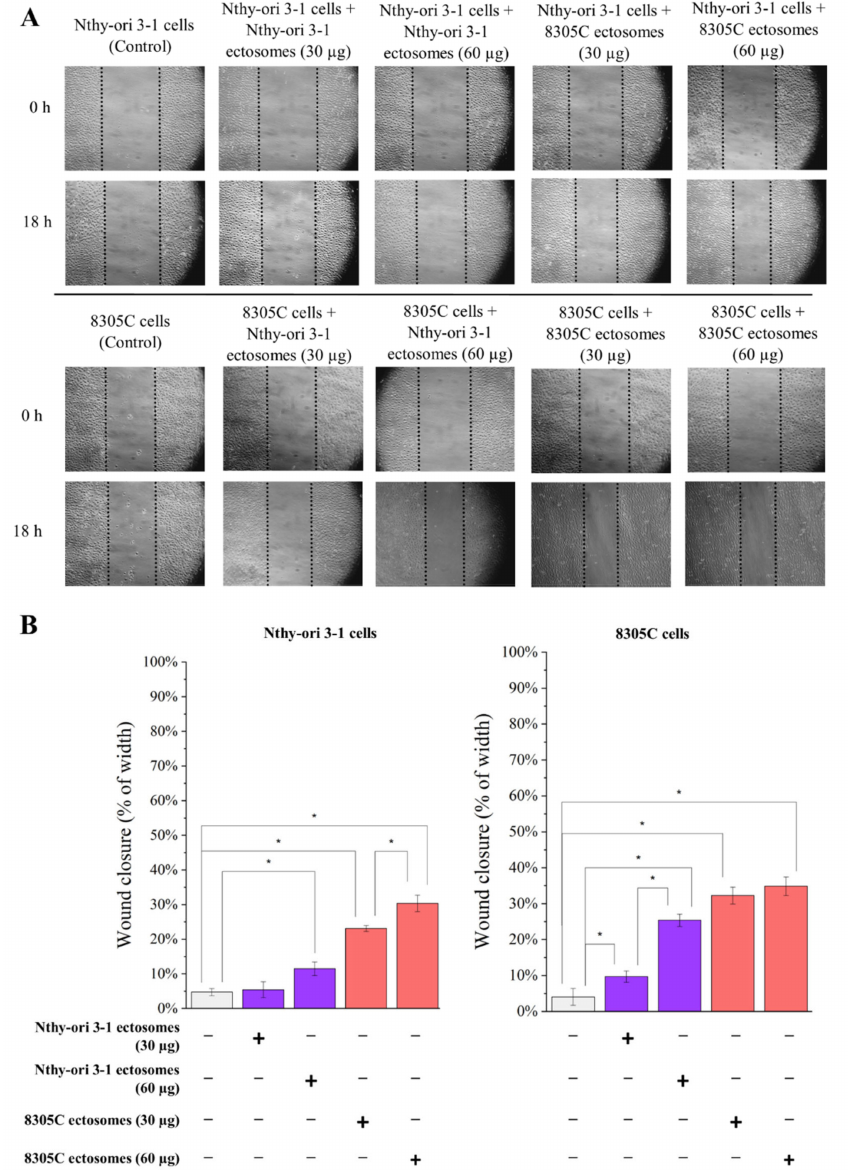
Figure 10. The effect of incubation of normal thyroid follicular epithelial Nthy-ori 3-1 cells and thyroid anaplastic carcinoma 8305C cells with ectosomes released by these cells. Wound closure assay was performed after 18 h of incubation with ectosomes. ( A ) Representative images were taken at 0 h and at 18 h. ( B ) Graphs presenting percentage of wound width closure calculated from three replicates. “*” denotes statistically significant differences (Tukey’s post hoc test, p -value < 0.05). Summing up, ectosomes derived from thyroid carcinoma 8305C cells displayed a compared to ectosomes derived from normal epithelial Nthy-ori 3-1 cells. Thyroid